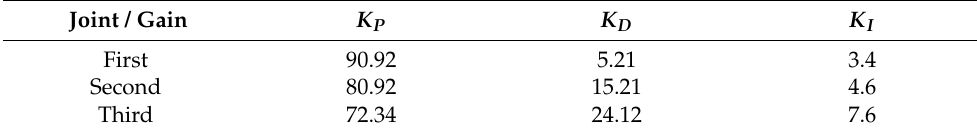
Table 1. Selected values of the PID controller and initial conditions for the adaptive